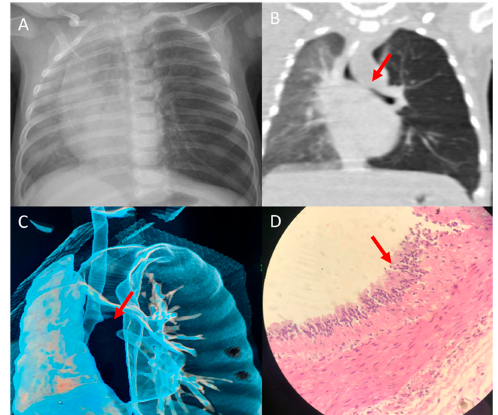
Figure 2. Chest X-ray (CXR) and chest computed tomography (CT) findings in case 3: ( A ) CXR of the patient on admission shows severe hyperinflation on the left side. ( B ) CT scan of the chest shows a hypodense cystic lesion in the middle mediastinum (arrow), causing compression on the distal trachea and the proximal aspect of the left mainstem bronchi, with resultant hyperinflation of the left lung. ( C ) Three-dimensional reconstruction of the CT scan shows a complete obstruction of the left main bronchus (arrow), caused by external compression of the adjacent fluid-filled cystic lesion. ( D ) Photomicrograph showing the cyst lined by ciliated pseudostratified columnar cells with a var- iable number of goblet cells filled with serous material. The cyst wall contains smooth muscle fibers with no granuloma or malignant cells (H&E, ×100 magnification). Case 4: A 60-month-old girl presented with a 3-day history of shortness of breath and 5 days of high-grade fever. A chest radiograph showed a consolidated lesion occupying the right middle lobe (Figure 3 A,B), and a chest CT scan revealed a well-circumscribed, rounded, 90 × 70 mm-diameter cyst on the right middle lobe, with an air bronchogram as- sociated with necrotizing characteristics and a central abscess measuring 6 cm at its greatest diameter. The patient was admitted and started on intravenous antibiotics, which alleviated the symptoms partially. Hence, pediatric surgery was consulted, and the patient underwent a lobectomy of the right middle lobe. Microscopic examination of the cyst revealed that the cyst wall was mainly composed of fibrous tissue with abundant chronic inflammatory and hemorrhagic cells. In addition, the cyst wall was partly lined with stratified squamous epi- thelium. The histopathological findings were consistent with an infected bronchogenic cyst. The patient was discharged eight days after resection and has remained in a stable condi- tion.